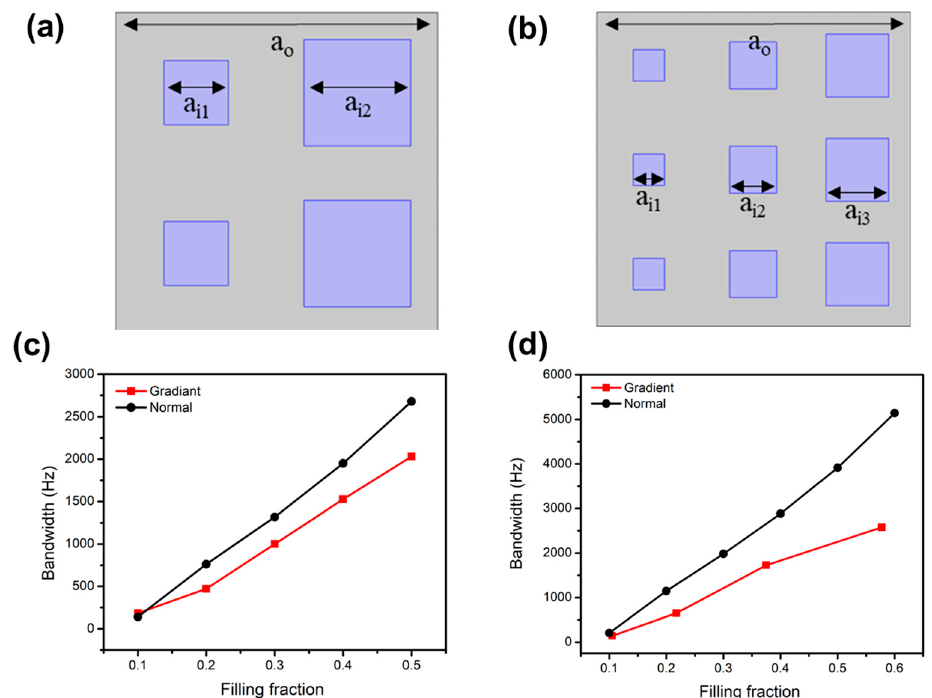
Figure 5. ( a ) Phononic crystals with four-square inclusions, where their dimensions are arranged in an increasing gradient. ( b ) Phononic crystals with nine-square inclusions, where their dimensions are set in a growing gradient of size. ( c ) The bandwidth of the phononic crystals with graded square inclusions plotted against their filling fraction for four inclusions. ( d ) The bandwidth of the phononic crystals with graded square inclusions plotted against their filling fraction for nine inclusions.